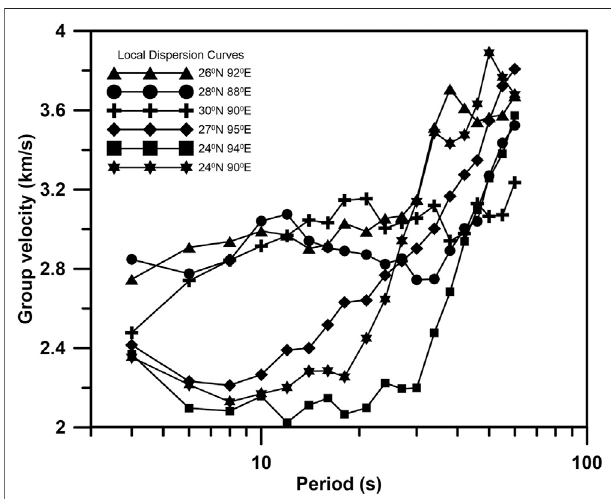
FIGURE4| Localdispersioncurvesforsixdifferentgridpoints(locations shown in Figure 1A ).